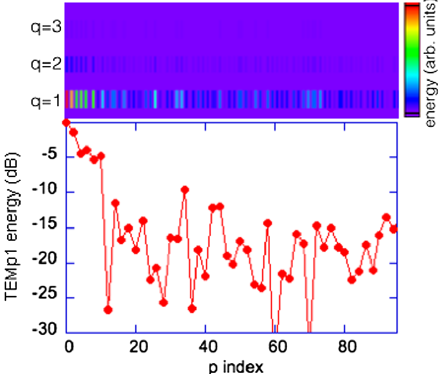
FIG. 8. Energy distribution of the eigenmodes TEM FLARE, at σ ¼ 50 cm − 1 , versus ð p; q Þ indexes, and bottom curve in dB for q ¼ 1 .